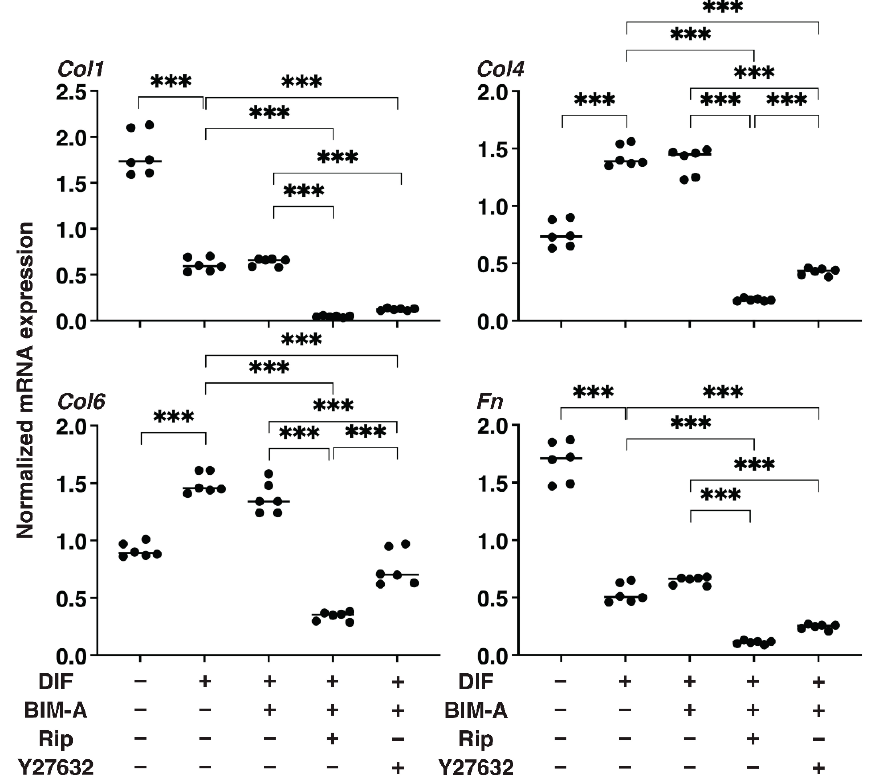
Figure 3. Additional effects of ROCK-i on BIM-A on the mRNA expression of ECMs of 2D planar cultured 3T3-L1 cells. The 2D planar cultures of 3T3-L1 cells were cultured under several conditions: preadipocytes of 3T3-L1 cells or their adipogenic differentiation (DIF) with or without the combination of 100 nM BIM-A (BIM-A) and ROCK-i (10 µ M Ripasudil (Rip) or 10 µ M Y27632). These specimens were subjected to qPCR analysis to estimate the mRNA expression of major ECMs ( Col : collagen, Fn : fibronectin). All experiments were performed in triplicate using fresh preparations, each consisting of 5 samples. Data are presented as the arithmetic means ± the standard error of the mean (SEM). *** p < 0.005 (ANOVA followed by Tukey’s multiple comparison test).